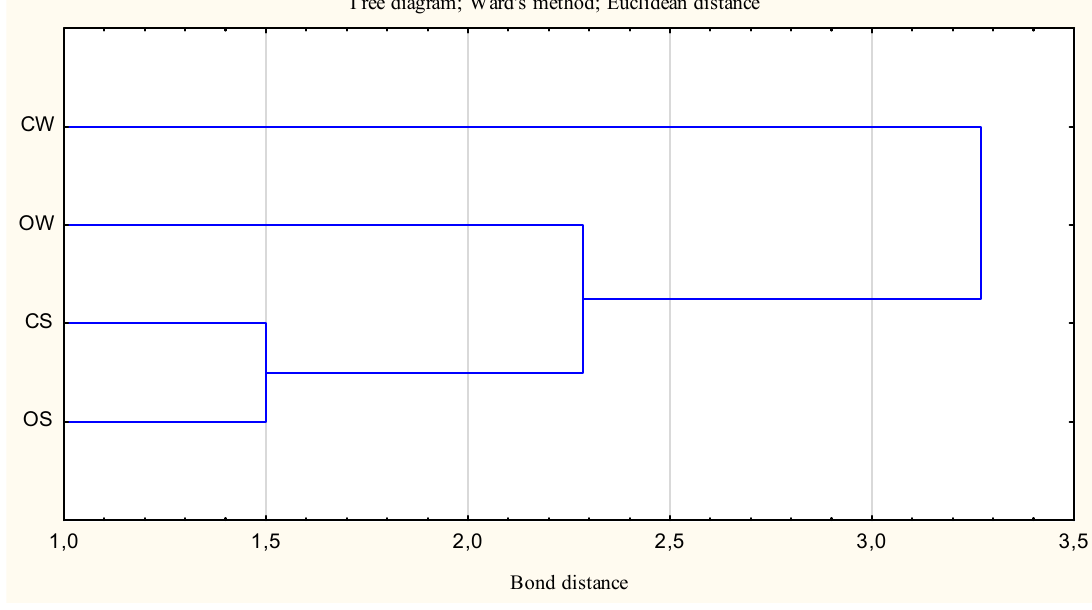
Figure 1. Tree diagram—Ward’s dendogram for TOC, TN and TOC/TN. Explanation: CW, OW, CS and OS—farming system and crop plant, as in Table 5.